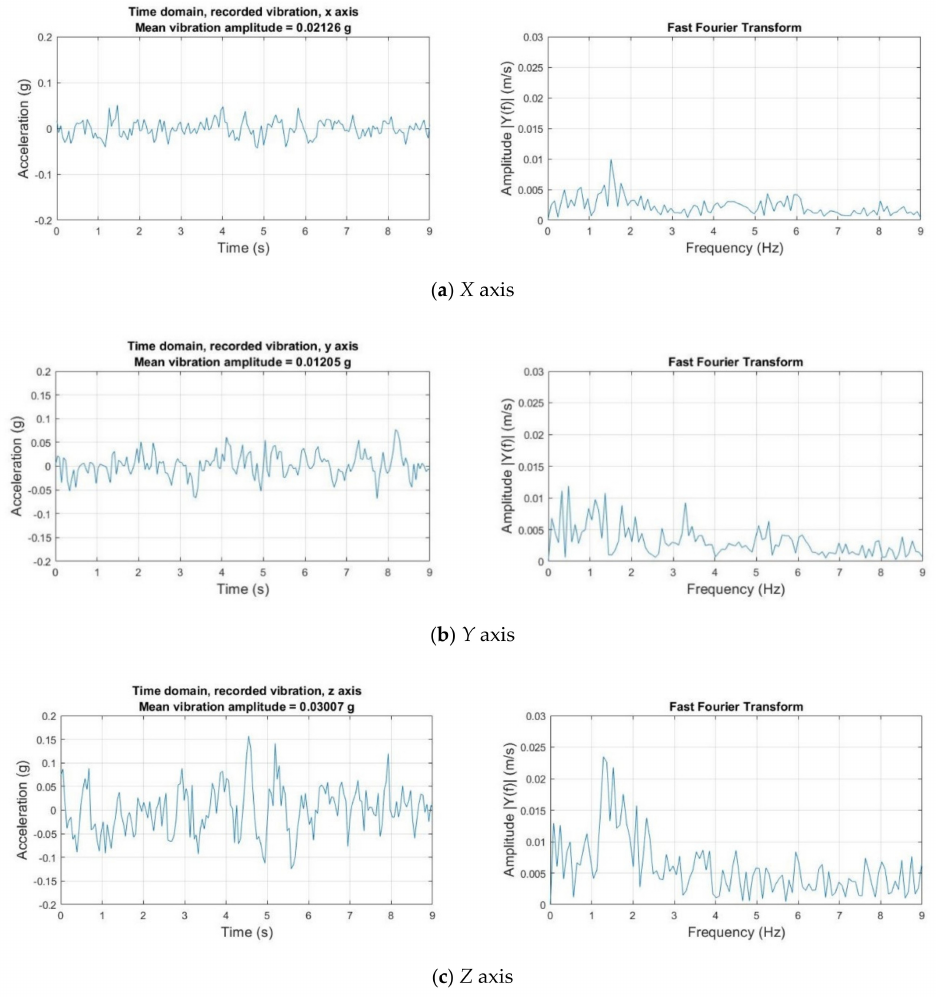
Figure 5. Representative environment vibrations for three axes of train cabin interior, including time domain vibration data and FFT